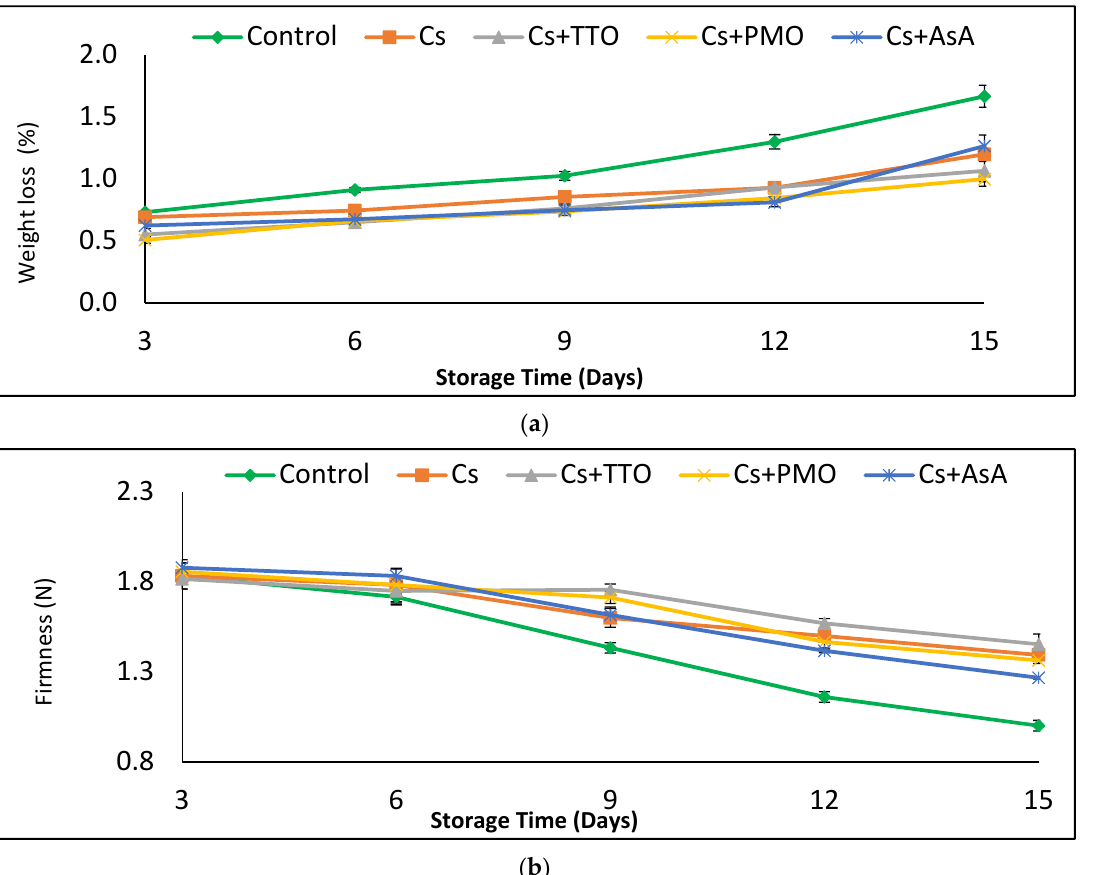
Figure 1. Effect of chitosan (Cs), Cs + tea tree oil (Cs + TTO), Cs + peppermint oil (Cs + PMO), and Cs + ascorbic acid (Cs + AsA) on ( a ) weight loss, and ( b ) firmness of fresh-cut green bean pods stored for 15 d at 5 °C. Error bars = SE, n = 6.